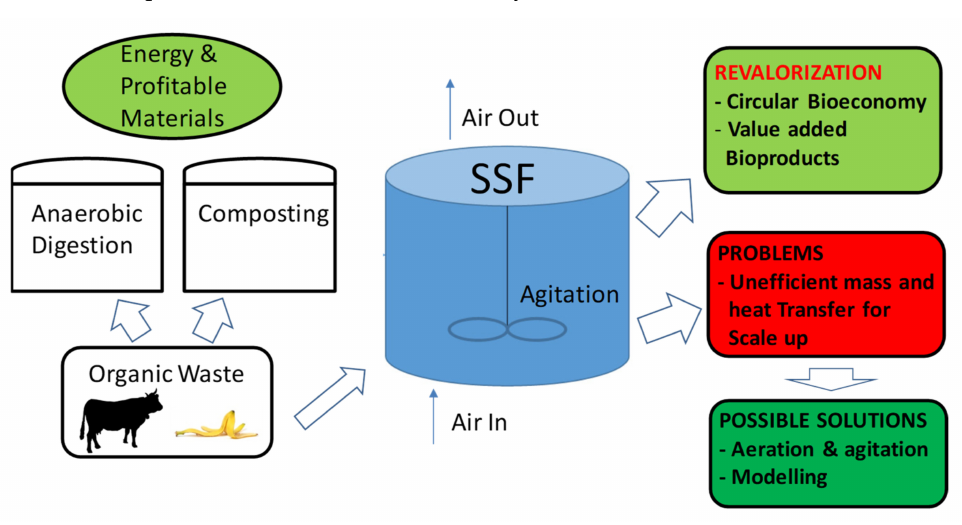
Figure 1. General overview of organic waste revalorization, with a special emphasis on SSF, its problems and possible